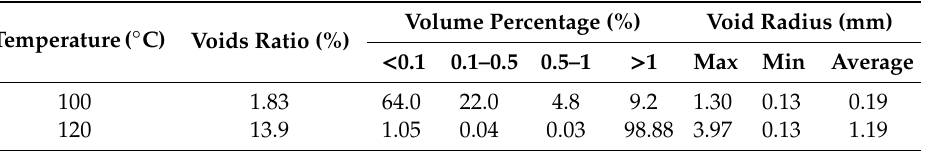
Table 7. Volume of voids in asphalt.